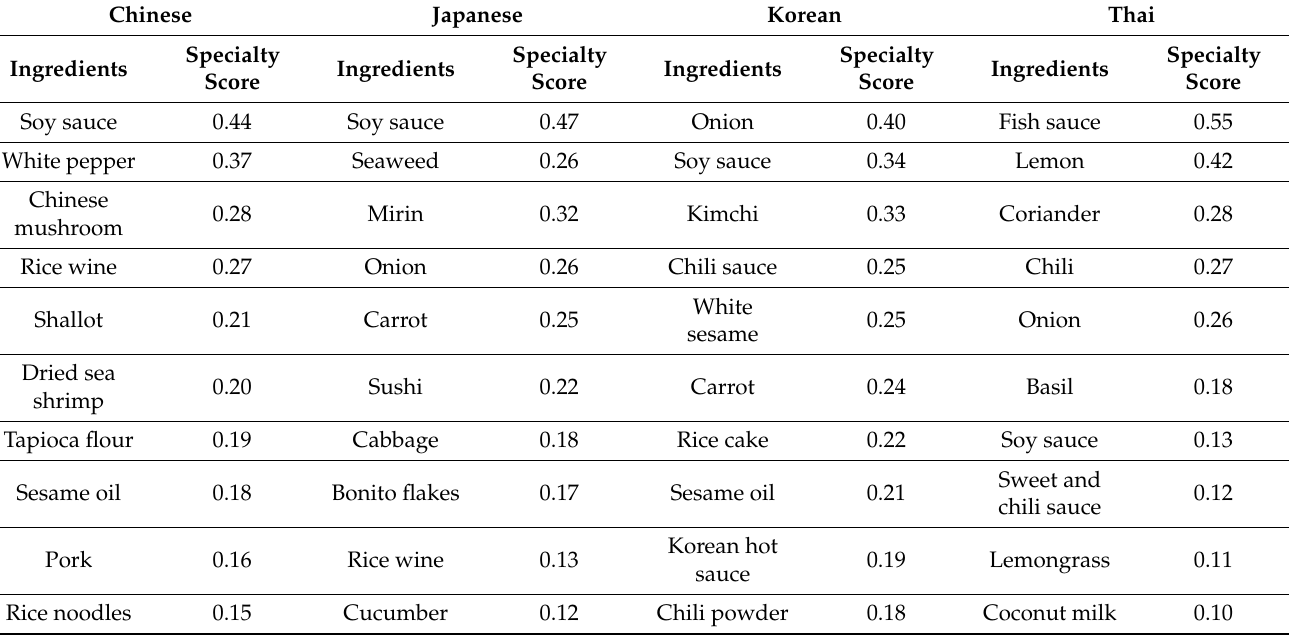
Table 2. Chinese, Japanese, Korean, and Thai cuisines’ Specialty score of